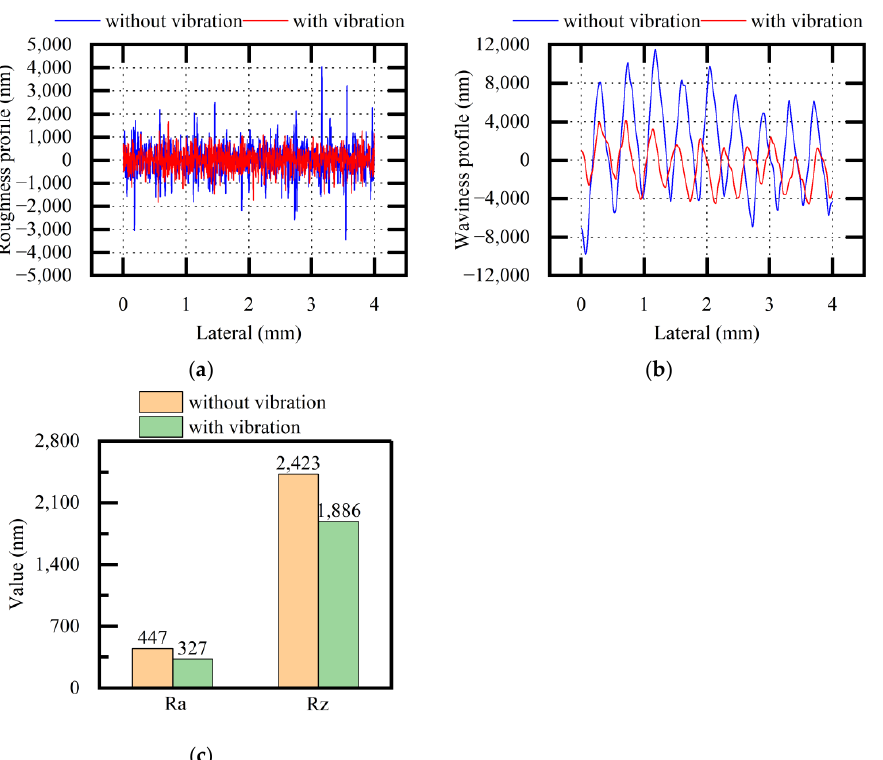
Figure 13. Comparative analysis of surface quality (stainless steel, variable f ): ( a ) roughness profile; ( b ) waviness profile; ( c ) average values of Ra and Rz.